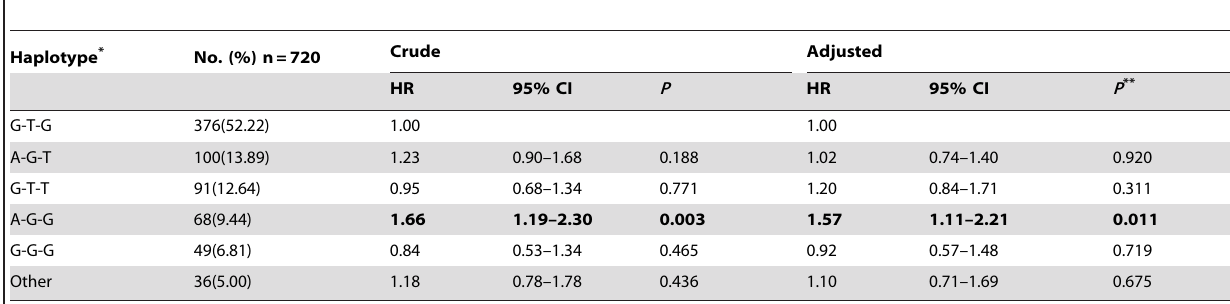
Table 3. Univariate and multivariate analyses of associations between ERCC1 and ERCC2 haplotypes and overall survival in gastric cancer